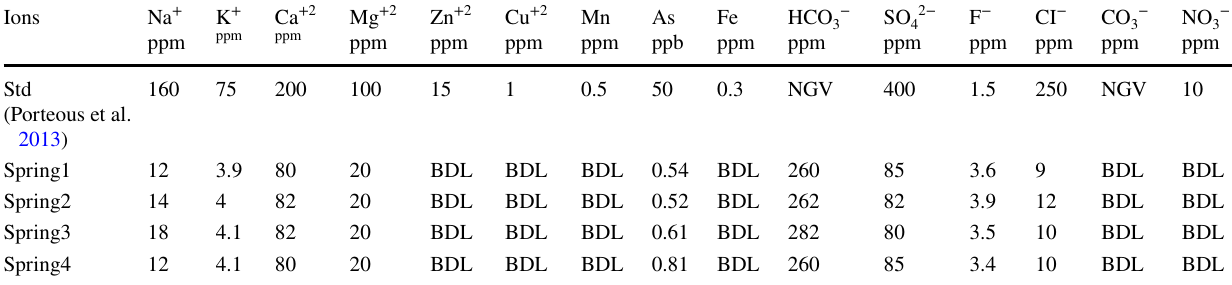
Table 2 Chemical analysis of thermal springs 1–4